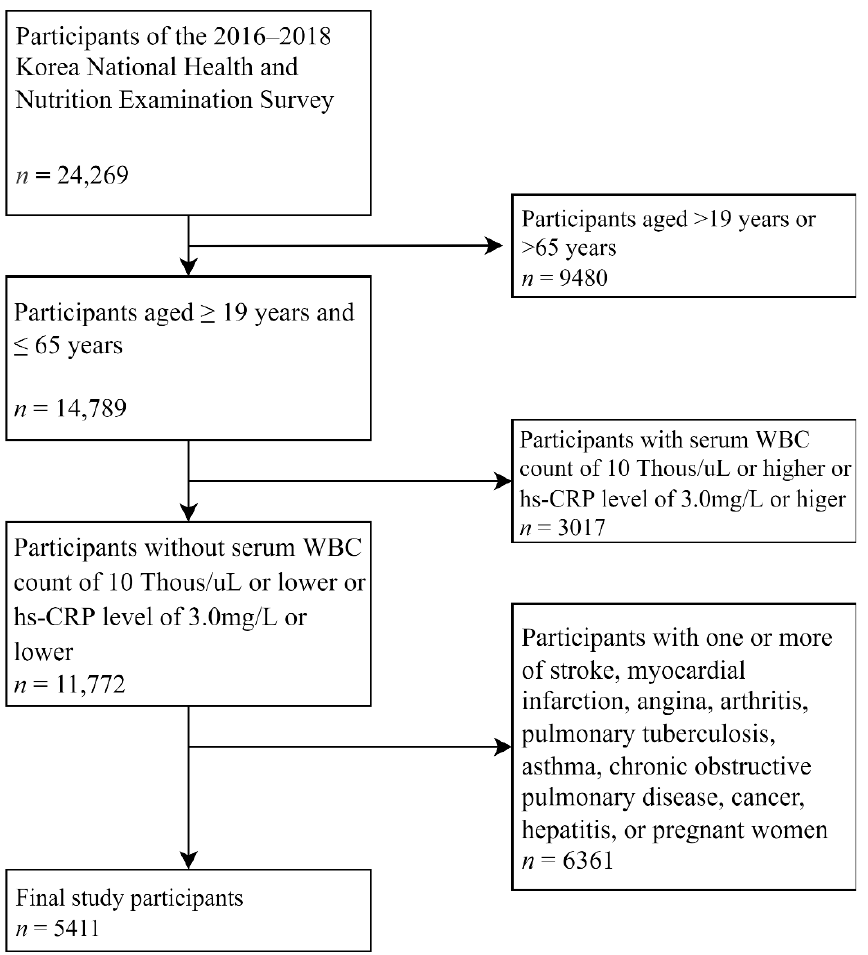
Figure 1. Flow diagram of the selection of study participants. WBC, white blood cell; hs-CRP, high sensitivity C-reactive protein.